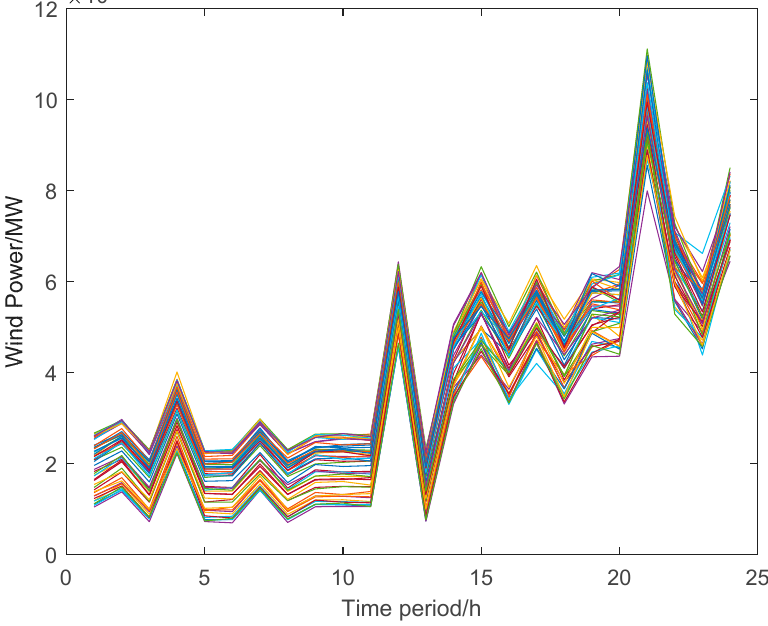
Figure 5. The scenarios of wind